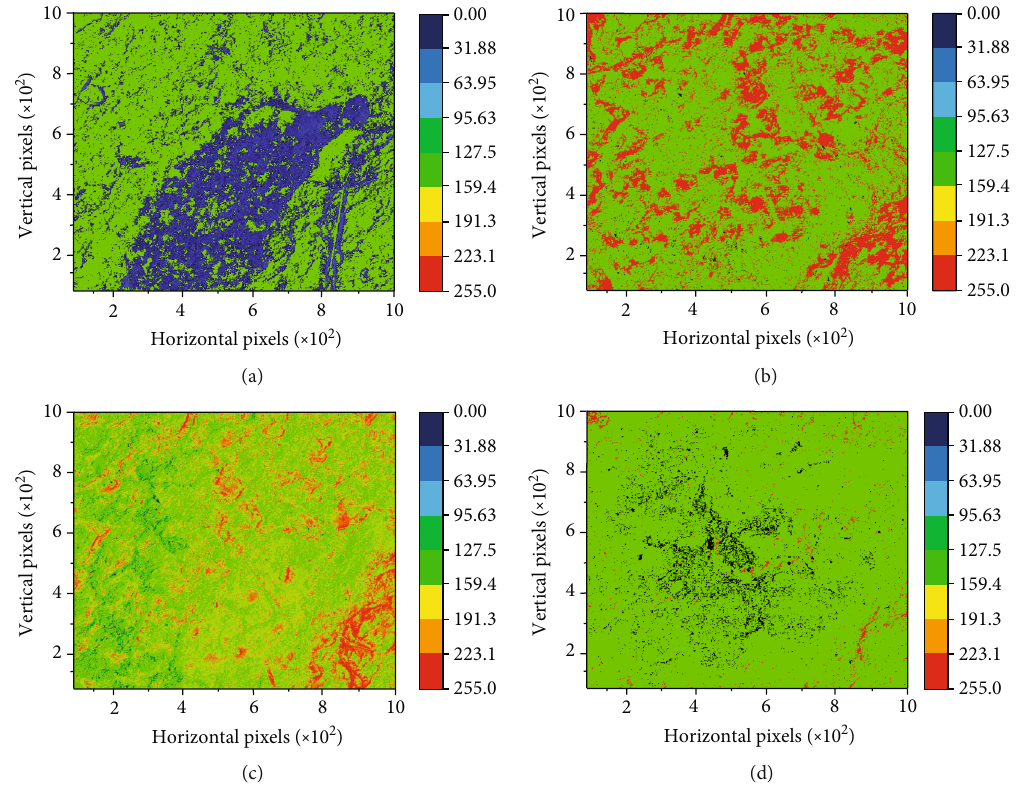
Figure 12: The color/gray distribution of oil shale before and after microwave heating. (a) Oil shale in initial state. (b) Oil shale at 300 ° C. (c) Oil shale at 400 ° C. (d) Oil shale at 500 ° C. Table 2: Data on holes before and after conductive